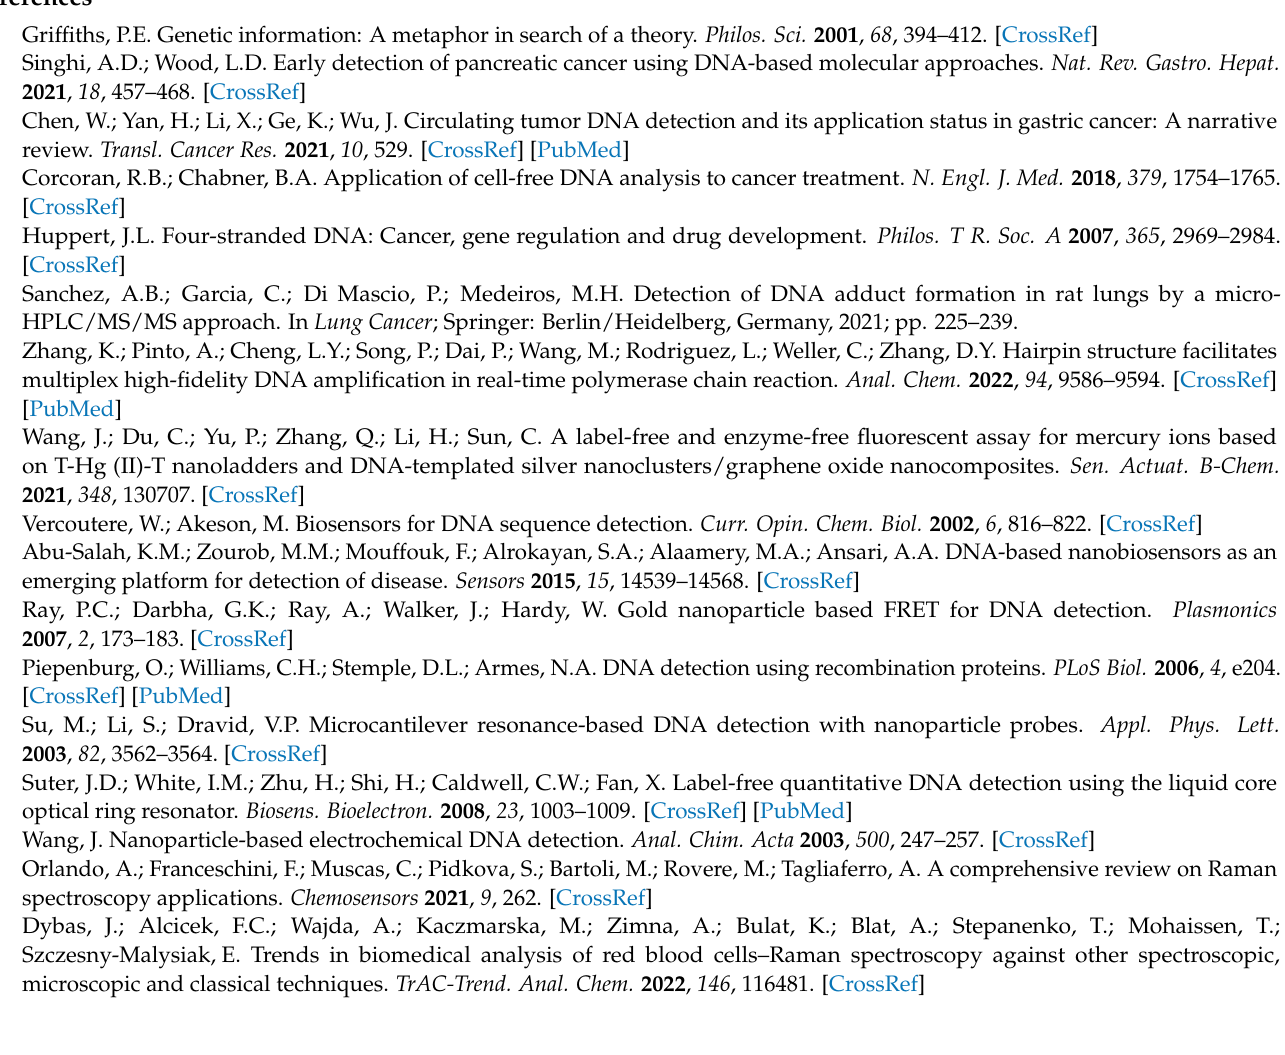
the D2; (c) the CD spectra of the D4. Figure S5: (a) the CD spectra of the tsDNA; (b) the CD spectra of the G-quadruplex. Table S1: the characteristic peak positions of DNA of different structures. Table S2: The motifs of tsDNA and G-quadruplex detected in the